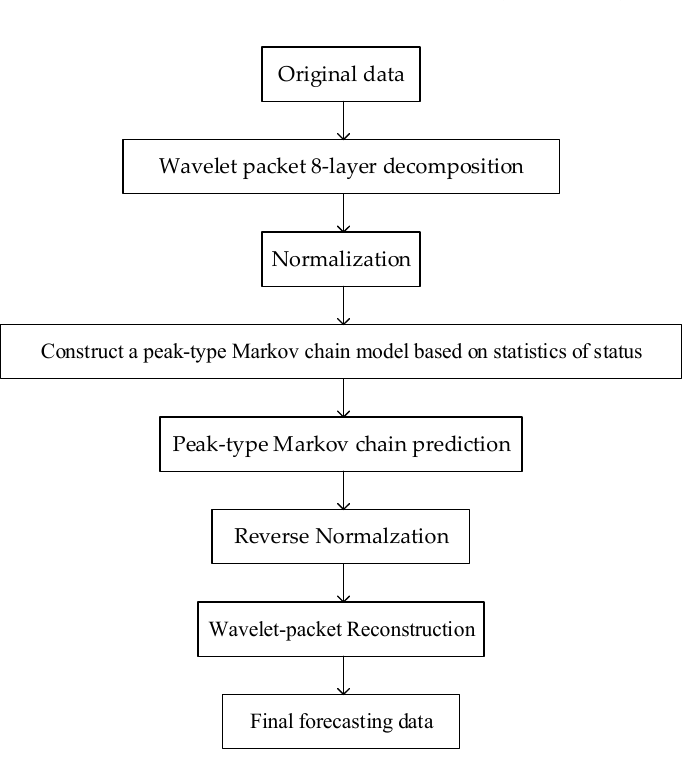
Figure 7. Basic structure of the proposed Wavelet peak-type Markov chain model.